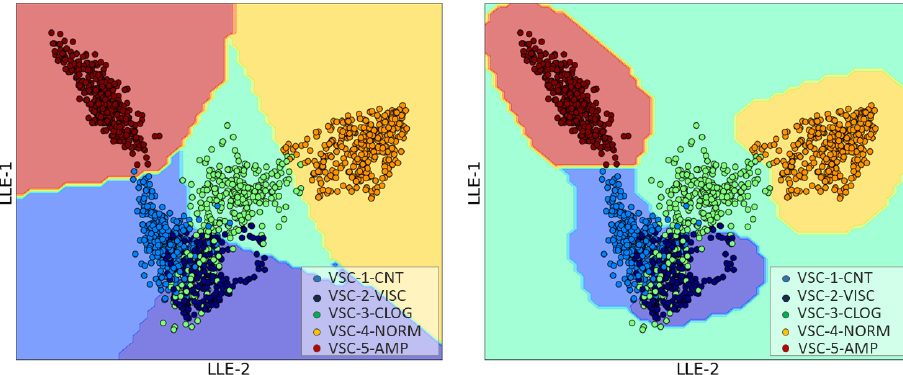
Figure 7. Fault isolation results of high-ranking features with ( Left ) showing classification perfor- mance of SVM-RFE and ( Right ) showing SVM-RBF with RFE classification